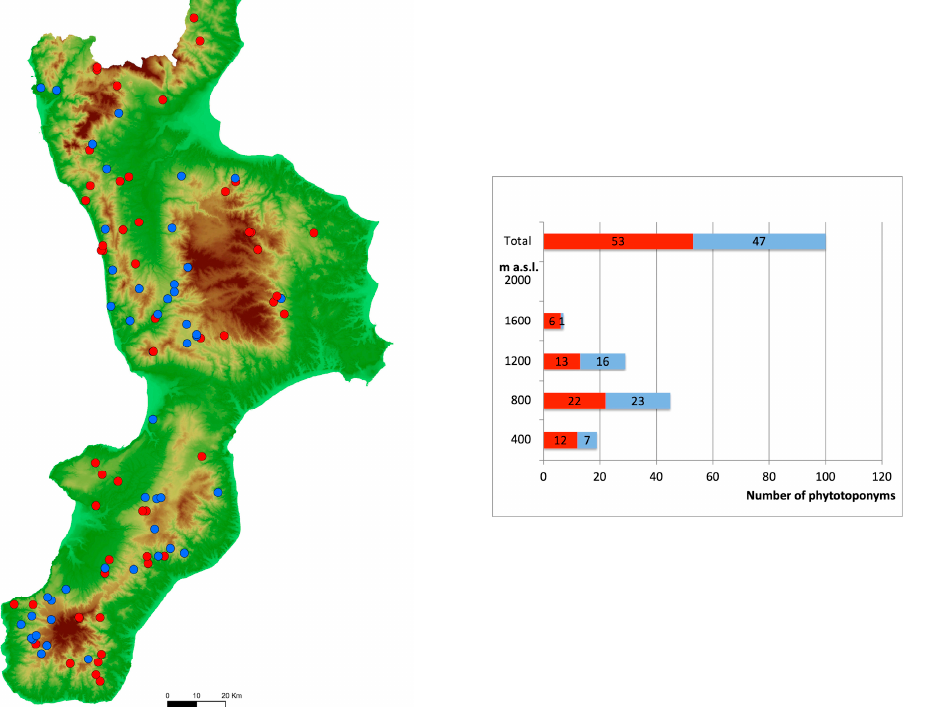
Figure 7. Distribution of phytotoponyms related to Castanea sativa Mill. on map and by altitudinal belt. Blue, agreement with current forest vegetation; red, no agreement.